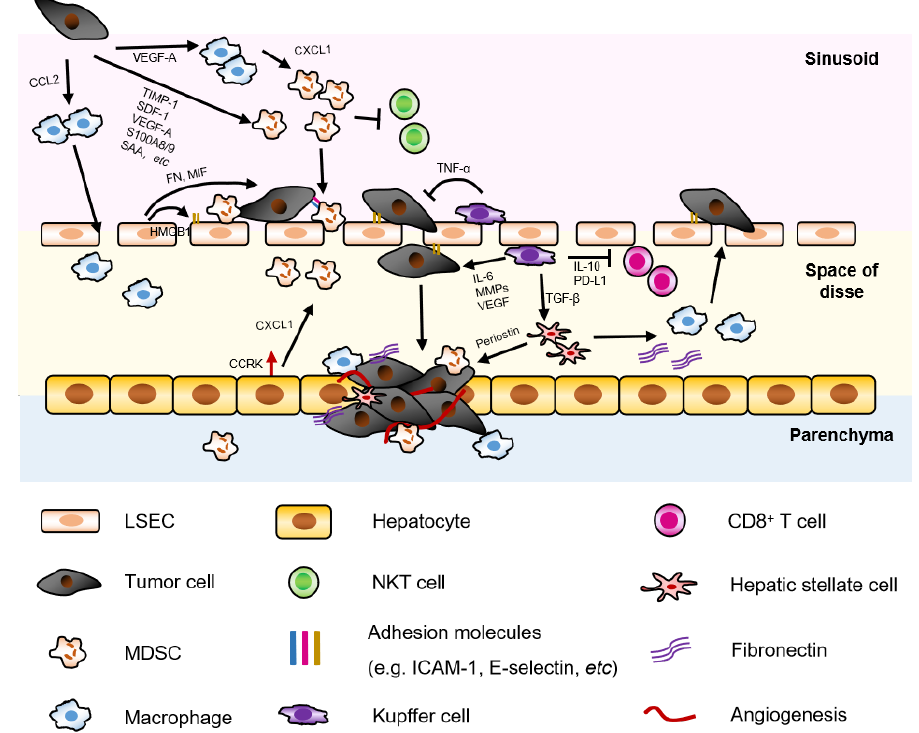
Figure 2. Immunoregulation of disseminated tumor cells by metastatic-prone liver immune microenvironment. The successful colonization of colorectal cancer cells in liver depends on the interaction between tumor cells and the liver immune microenvironment. The primary tumor cells secrete multiple factors to recruit MDSCs and macrophages in liver, which suppresses NKT cells, facilitates the arrest and invasion of the tumor cells and promotes angiogenesis. LSECs support the arrest, retention, and transmigration of tumor cells by the expression of adhesion molecules, and secrete fibronectin (FN) and MIF to induce EMT phenotype in CRC cells. Kupffer cells can both inhibit tumor cell growth by secretion of TNF-α and support tumor cell metastasis via suppression of CD8+T cells, activation of HSC, and promoting tumor cell invasion. The activated HSCs upregulate fibronectin, recruit macrophage to promote adhesion of disseminating tumor cells, and secrete periostin to enhance angiogenesis.